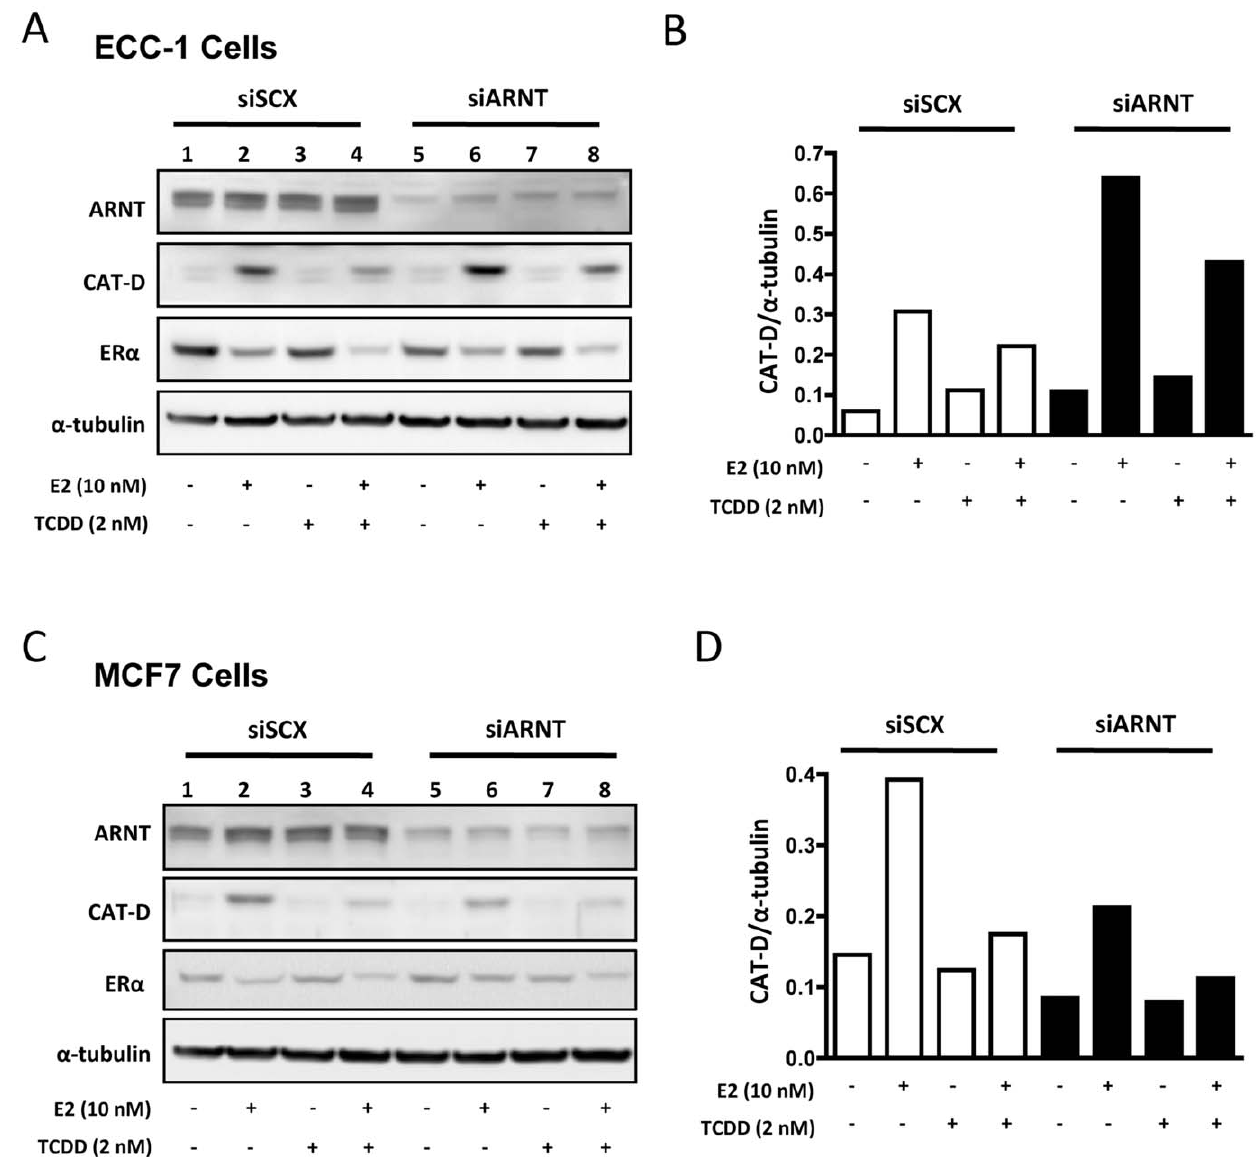
Figure 3. Effect of ARNT knockdown on ARNT, CAT-D and ER a protein levels. ECC-1 ( A and B ) and MCF7 ( C and D ) cells were transfected with either siSCX or siARNT and ligand treated as described in Figure 2. ( A and C ) Representative Western blots of ARNT, CAT-D, ER a and a -tubulin protein levels. Bar graphs of CAT-D protein levels in ECC-1 ( B ) and MCF7 ( D ) cells after normalizing luminescence values to a -tubulin. Open bars represent ligand treatments after siRNA to scrambled negative control (siSCX) and closed (black) bars represent ligand treatments after siRNA to ARNT (siARNT). Experiments were performed three times with essentially identical outcomes.